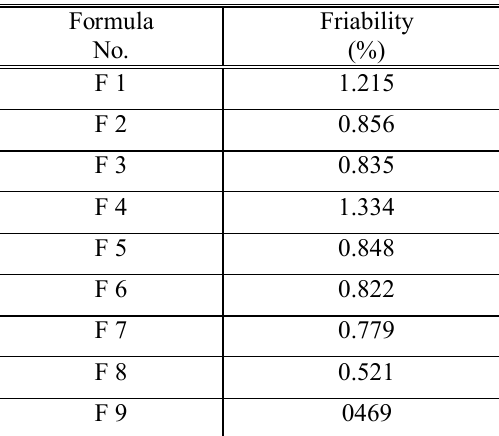
Uniformity of Dosage Units